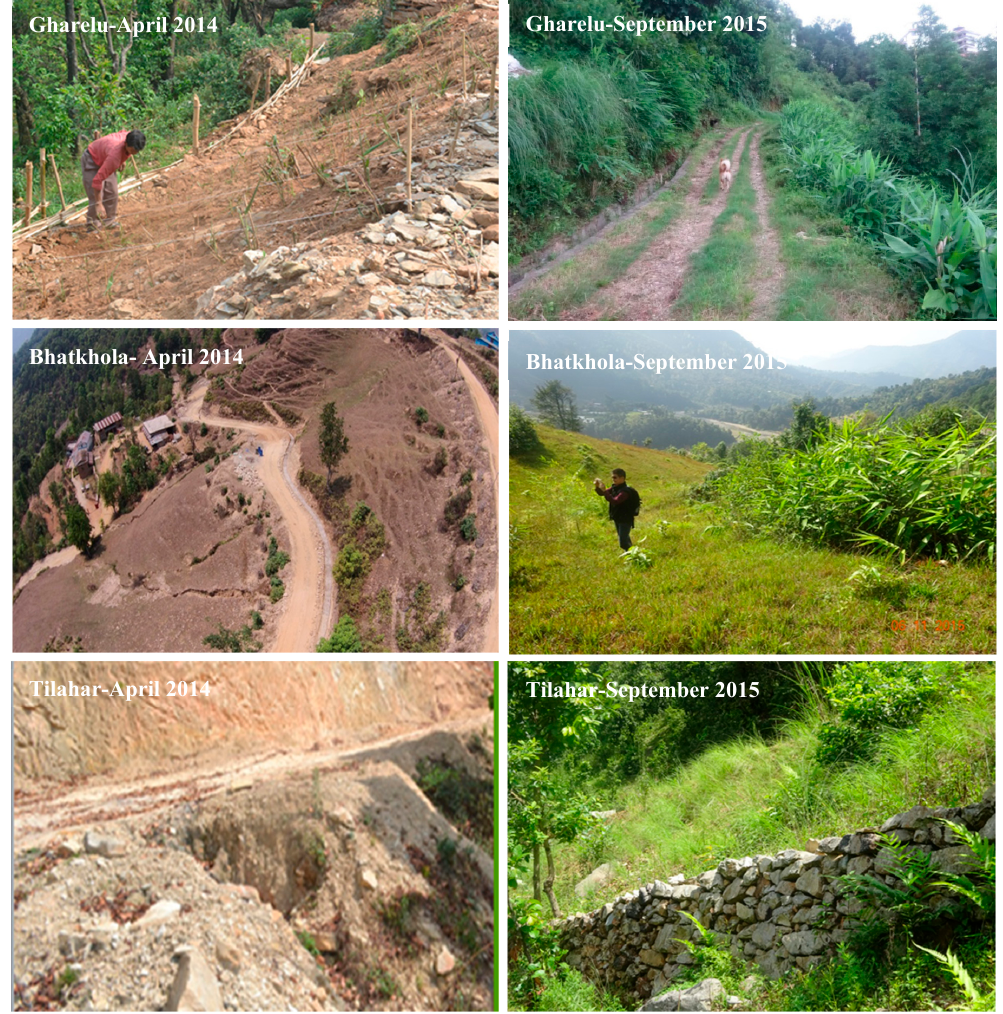
Figure 3. View of the demonstration sites before and after 18 months of establishment.